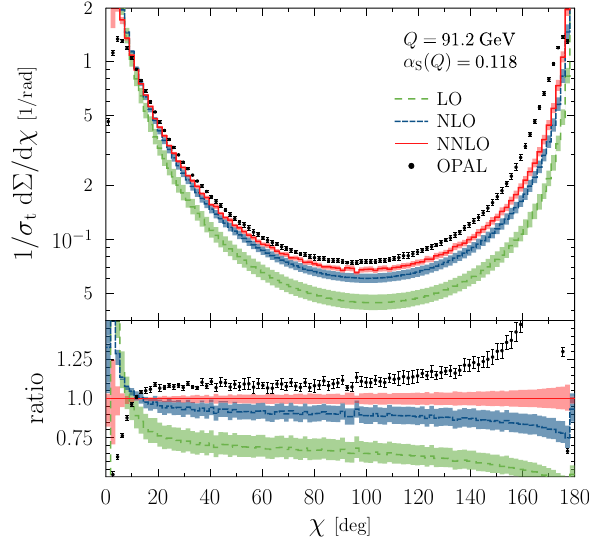
Fig. 1 Fixed-order predictions for EEC at LO, NLO and NNLO accu- racy. The bottom panel shows the ratio of the data and the perturbative predictions at each order to the NNLO result. The bands represent the effects of varying the renormalization scale by a factor of two around the default scale of μ = Q . OPAL data is also